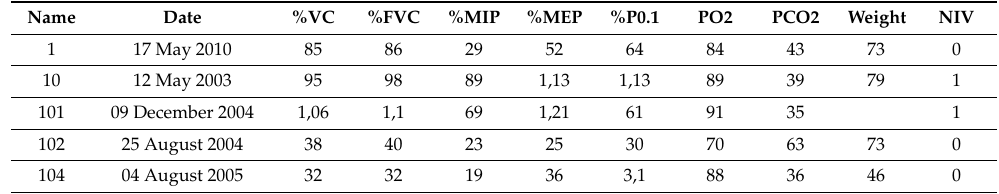
Table 8. RFT output table; generated using RFT and demographics (NIV—non-invase